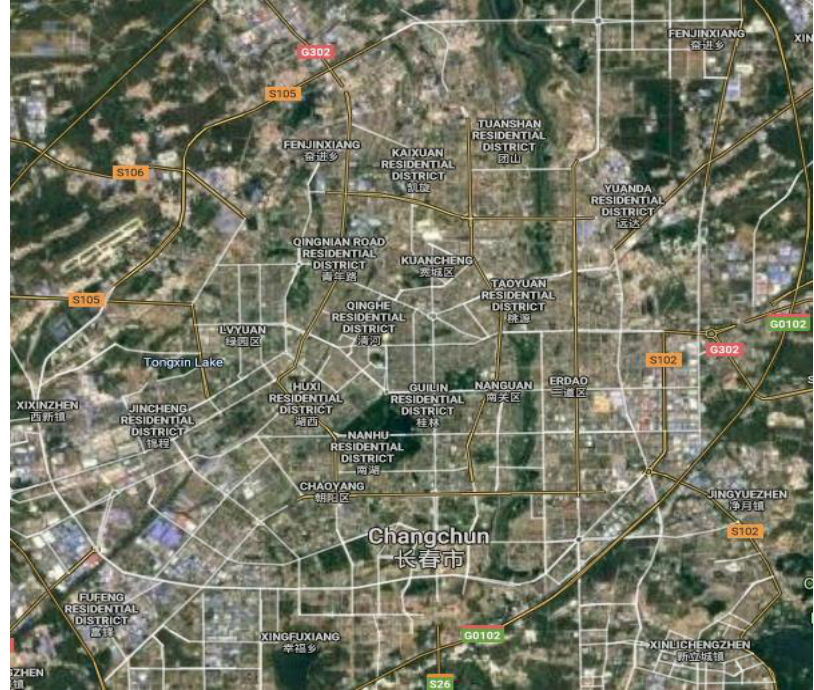
Figure 1. The intersection distribution map in GPS data.